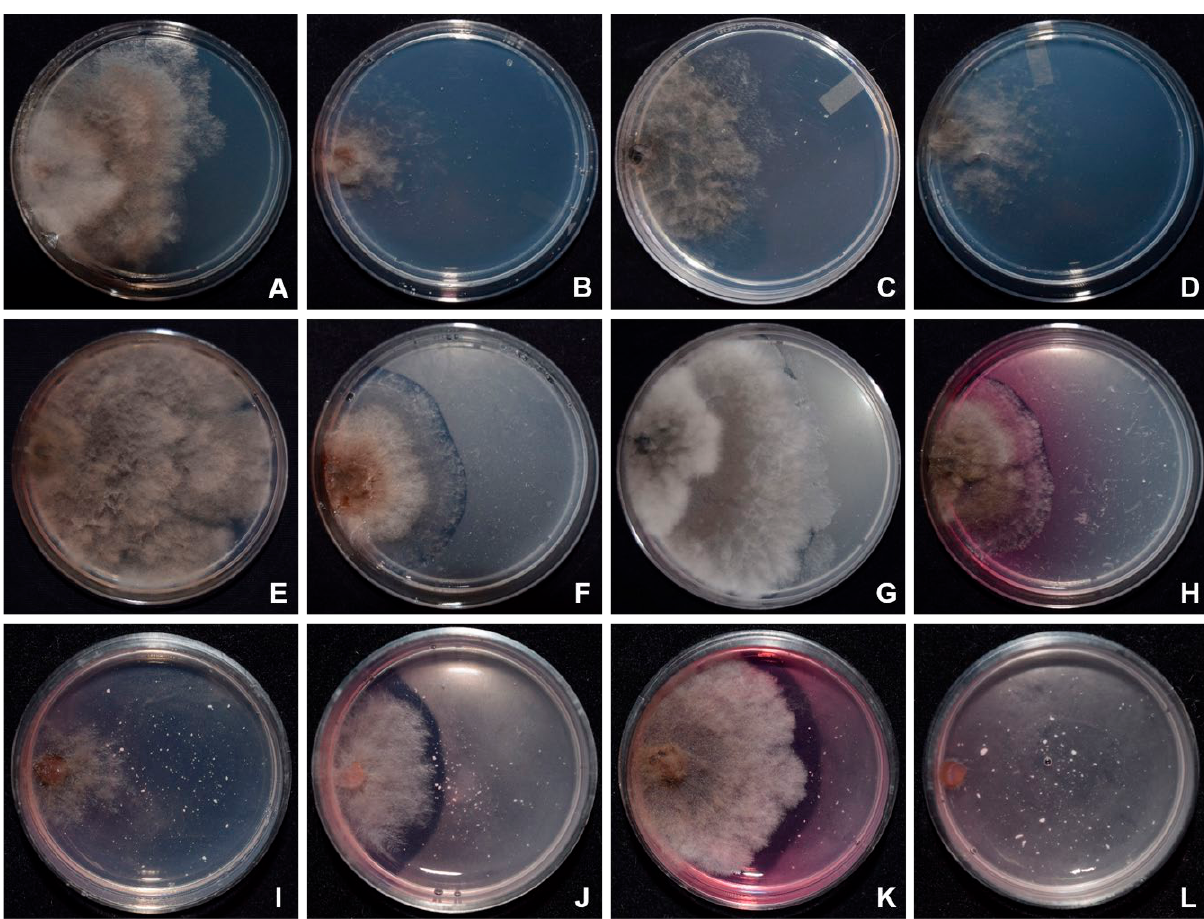
Figure 5. Assessment of effects of tyrosine on growth in Lasiodiplodia gilanensis . A) Minimal Medium 9 (MM9). B) MM9 without carbon source (MM9-C). C) MM9 without nitrogen source (MM9-N). D) MM9 without carbon and nitrogen sources (MM9-CN). E) MM9 + 10 mM tyrosine (Tyr). F) MM9-C + Tyr. G) MM9-N + Tyr. H) MM9-CN + Tyr. I) MM9-CN + Tyr + 15 μg·mL -1 tropolone (Tp) , DOPA- melanin inhibitor. J) MM9-CN + Tyr + 500 μg·mL -1 phthalide (Ph), DHN-melanin inhibitor. K) MM9-CN + Tyr + 100 μg·mL -1 nitisinone (NTBC), pyomelanin inhibitor. L) MM9-CN + Tyr + Tp + Ph +